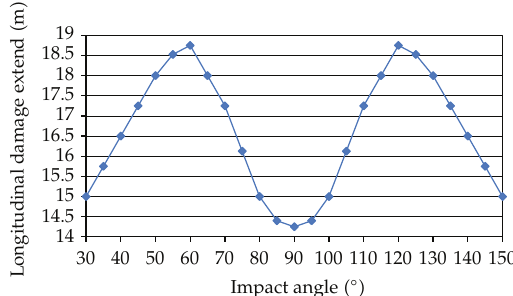
Figure 21: Sensitivity of longitudinal damage extent to impact angle.